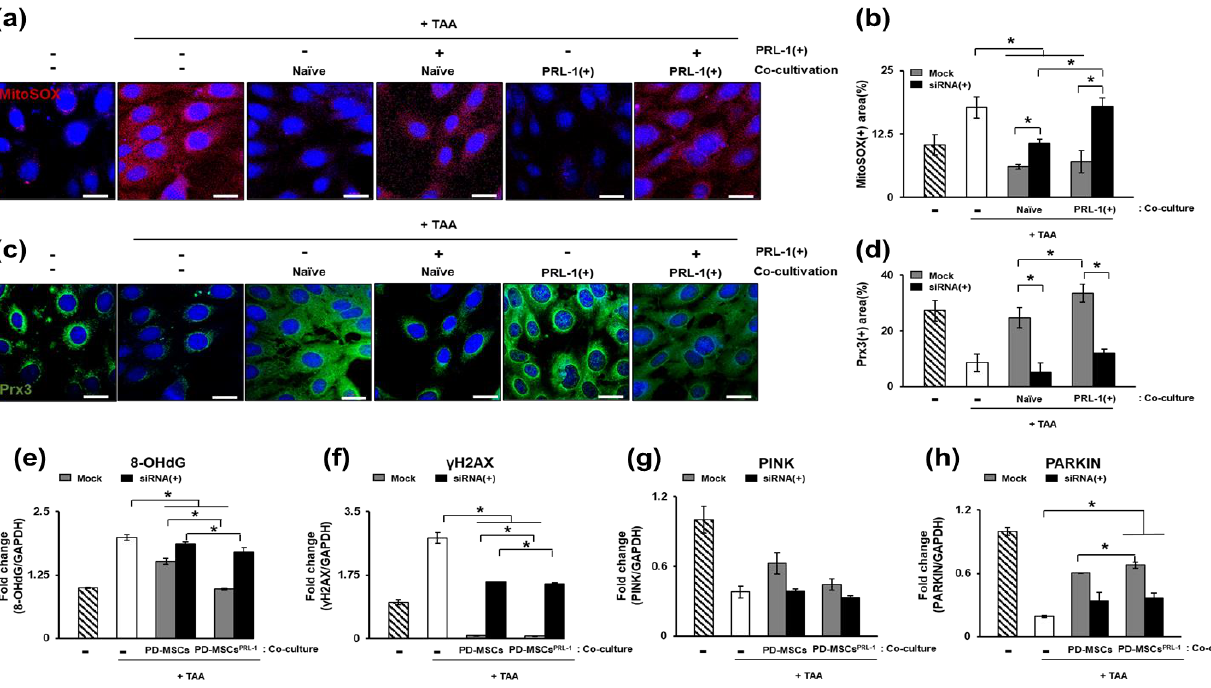
Figure 7. Expression of antioxidants in TAA-treated WB-F344s. The expression of antioxidant markers in TAA-treated WB-F344s ( a ) and ( b ) MitoSOX, ( c ) and ( d ) Prx3, ( e ) 8-OHdG, ( f ) γH2AX, ( g ) PINK, and ( h ) PARKIN. All experiments were repeated in duplicate to triplicate. * p < 0.05.